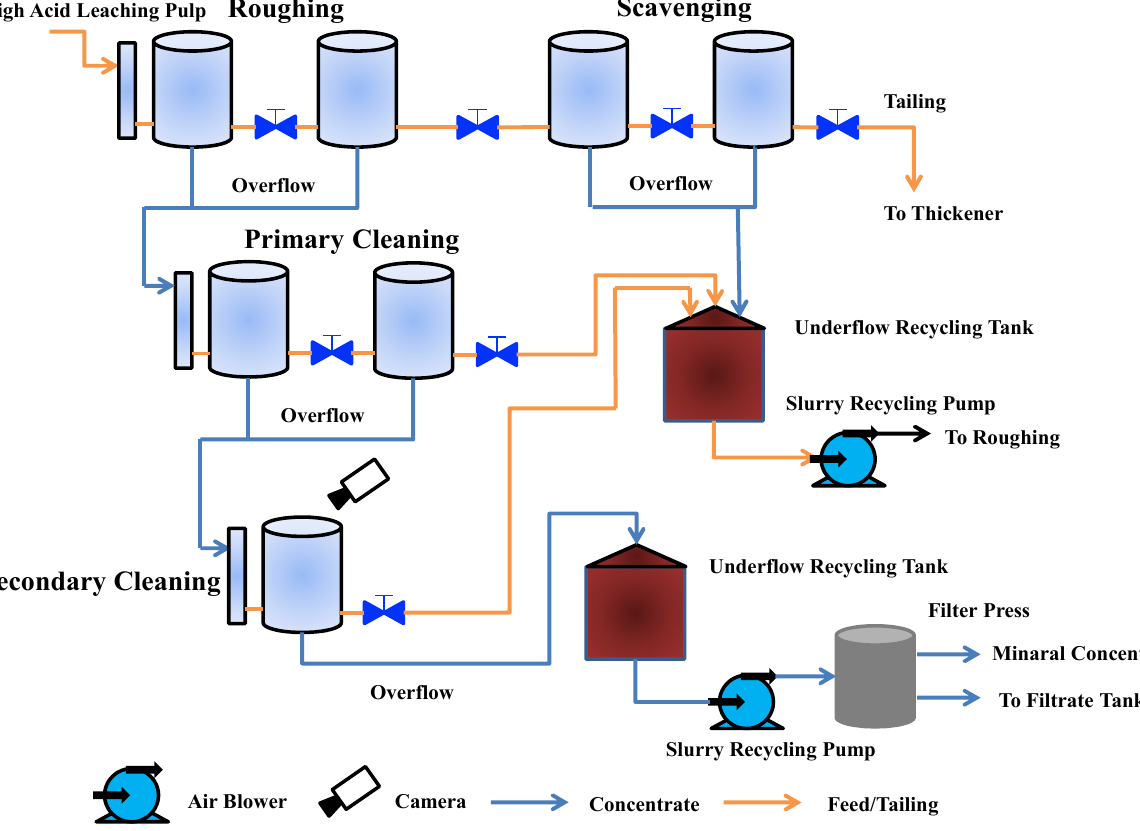
Figure 11. The flow chart of mineral flotation process.